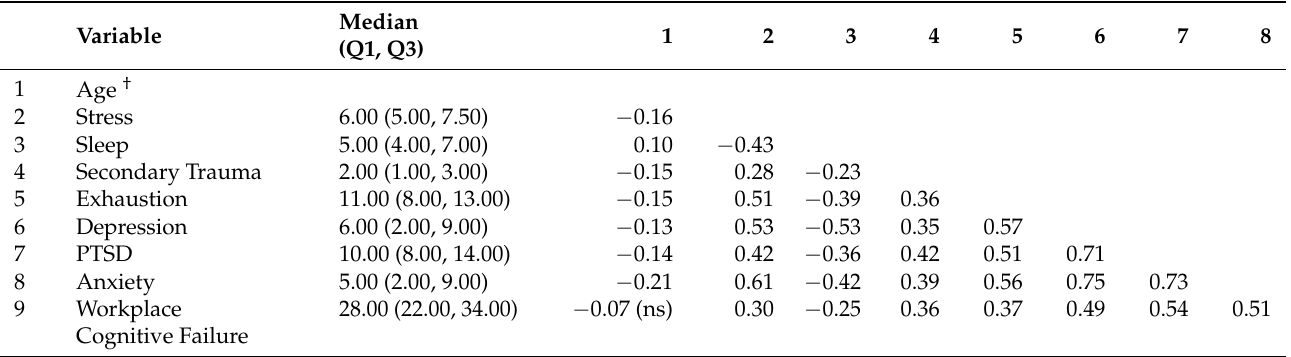
Table 2. Descriptive statistics and bivariate correlations among study